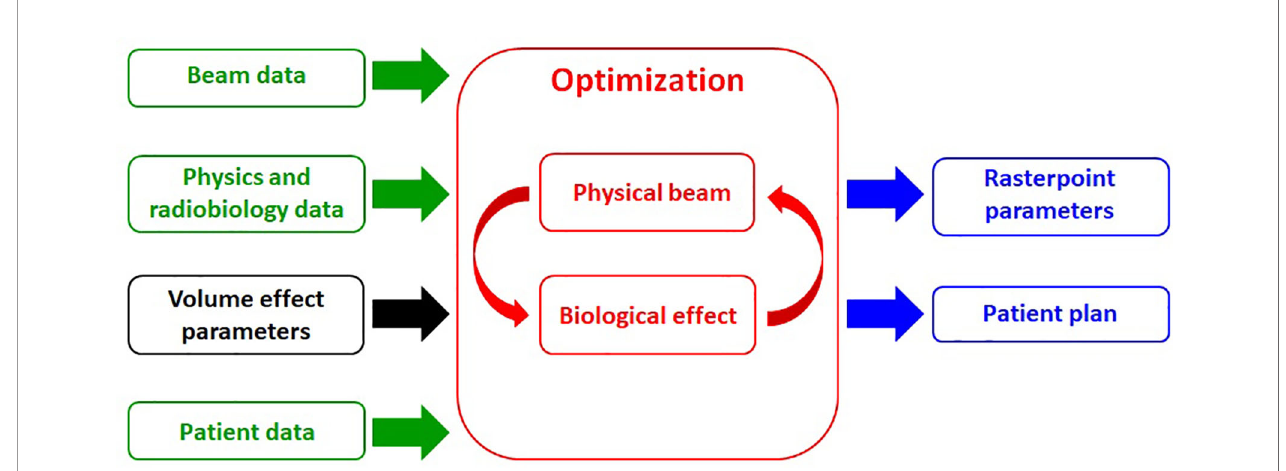
FIGURE 1 | Simpli fi ed fl owchart structure of TRiP98: input data (green boxes), including the extension developed in this work, i.e., the implementation of a generalized equivalent uniform dose (gEUD)-based objective in the optimization procedure (black box); optimization task (red boxes); output data (blue